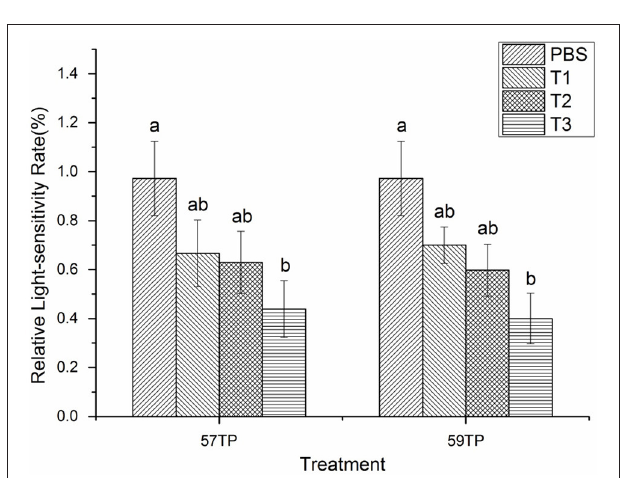
FIGURE 5 | Light-sensitivity changes before and after the RNAi interference of the CGI_10012534 gene. Notably, 57TP indicates the siRNA-57 targeted treatment group and 59TP indicates the siRNA-59 targeted treatment group. PBS indicates the group treated with PBS ( n = 6), T1 indicates the group treated with 5 µ g/100 µ l siRNA ( n = 6), T2 indicates the group with 10 µ g/100 µ l siRNA ( n = 6), and T3 indicates the group with 15 µ g/100 µ l siRNA ( n = 6). Each bar represents the mean of six independent experiments. Different letters indicate a significant difference ( P <